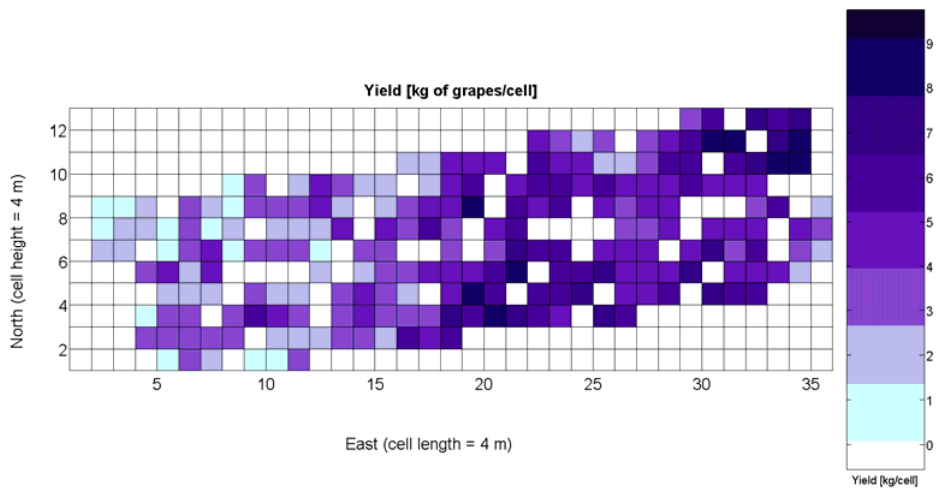
Figure 9. CB map of grape yield (kg of grapes/16 m 2 ).